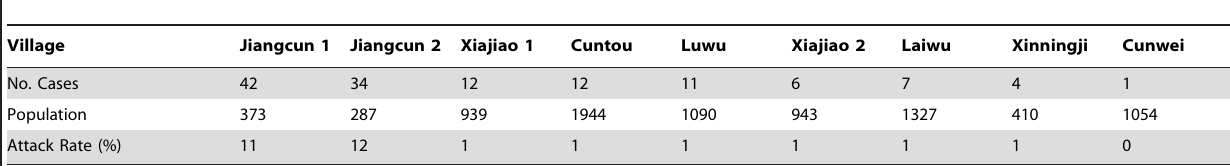
Table 2. Attack rates of CHIK fever confirmed cases in different villages in the Xincun community.